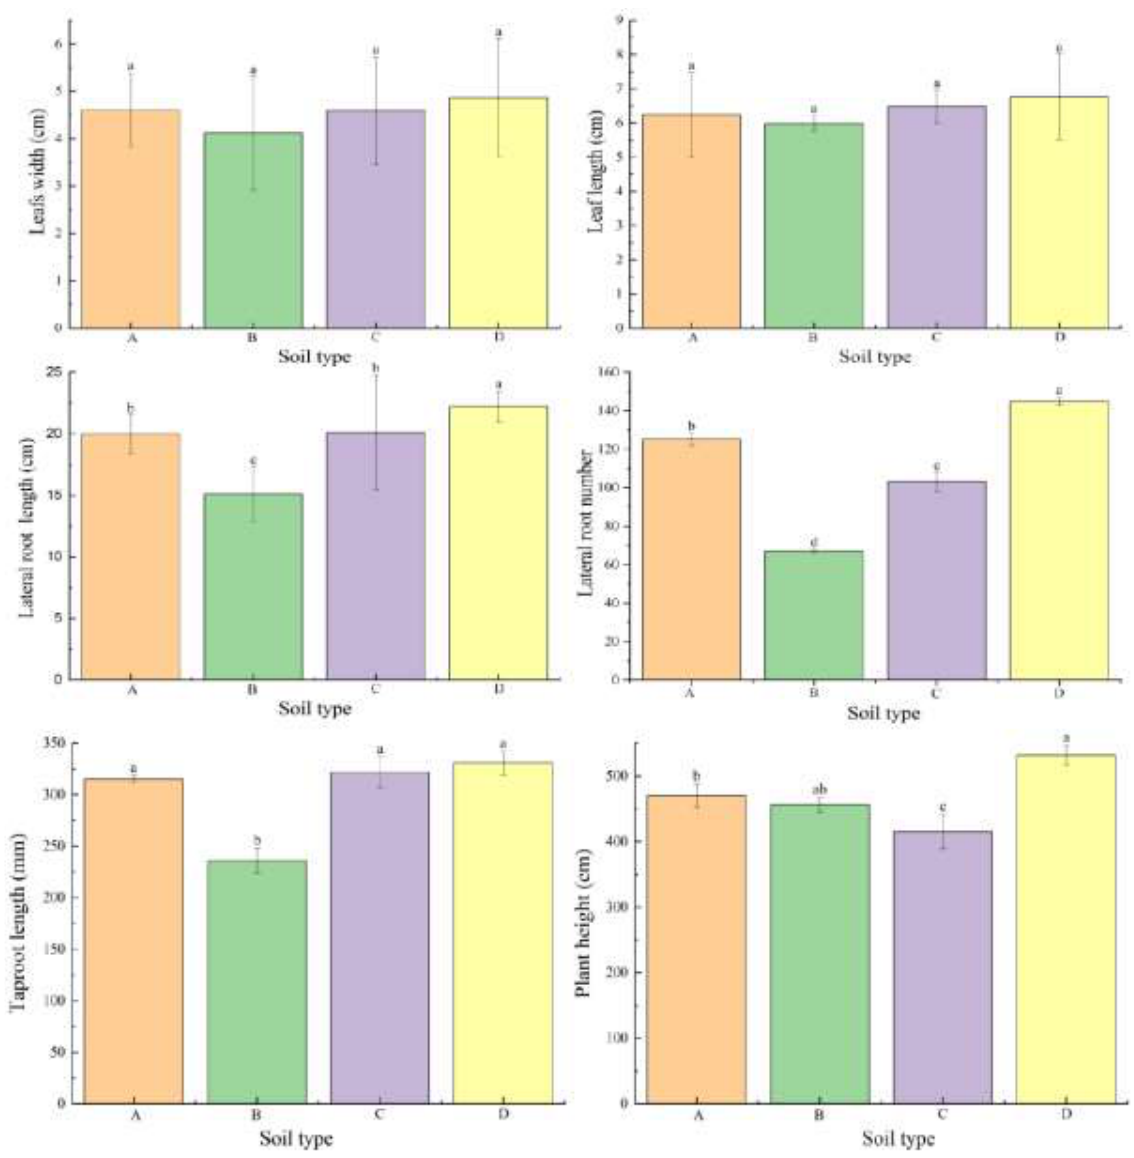
Figure 1. The effects of different media on the growth of poplar. A: sand + ½ MS; B: clay + ½ MS; C: loam + ½ MS; D: vermiculite + ½ MS. The graphical values denote the means for n = 4; the bar is four experimental averages; bars with different a, b, and c letters are significantly different (ANOVA, p < 0.05).